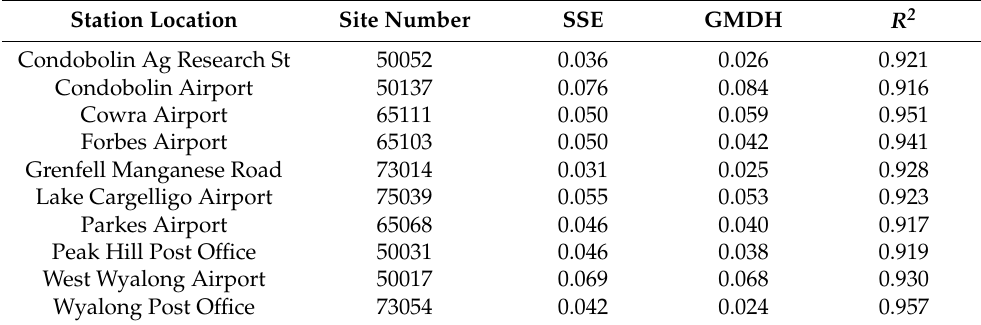
Table 2. Trends of the mean maximum temperature increase ( ◦ C/year), using SSE and GMDH methods along with the coefficients of determination ( R 2 ) for the success in GMDH